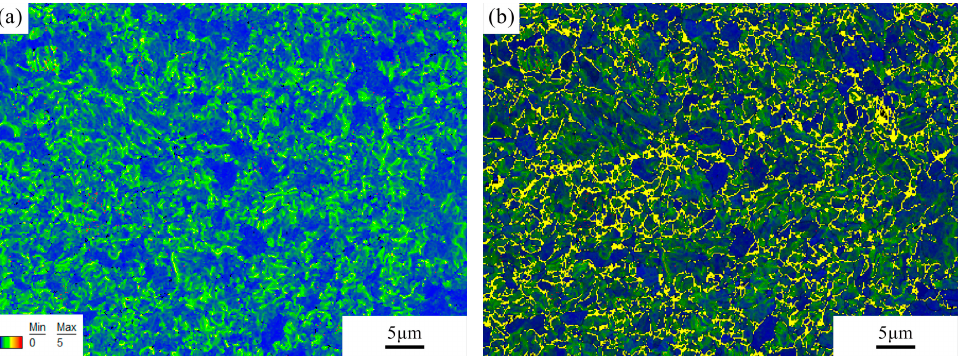
Figure 9. ( a ) Kernel average misorientation (KAM) map of the fusion zone in the heat-treated joint (P = 2500 W, t = 5 ms) and ( b ) Kernel average misorientation (KAM) map combined with image quality (IQ) map shown in Figure 8b.